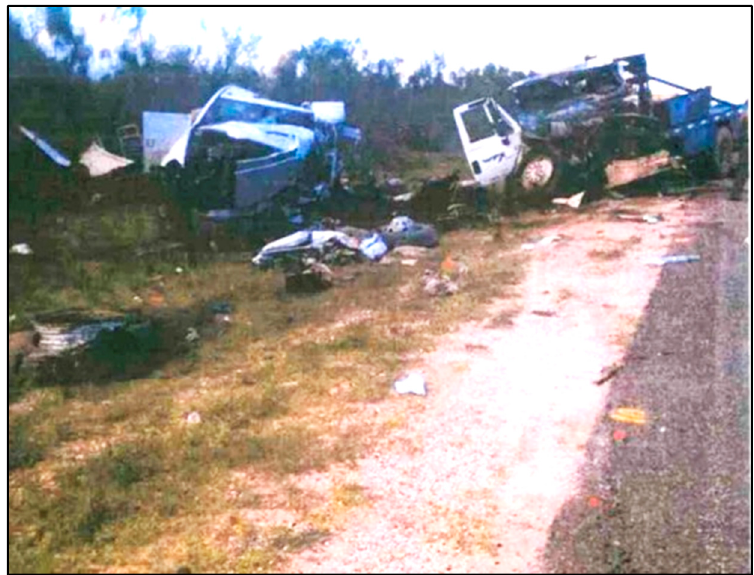
Figure 3. Scene photo depicting final rest for both vehicles.